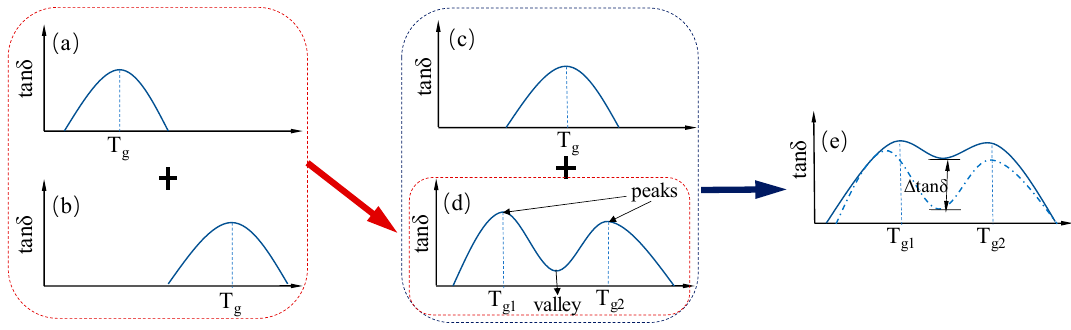
Figure 5. Variation of dynamic mechanical analysis (DMA) temperature spectrum of blends with miscibility of component polymers; ( a ), ( b ) and ( c ) are the DMA temperature spectrum of the component high polymer, respectively; in ( d ) and( e ), the miscibility increases sequentially.